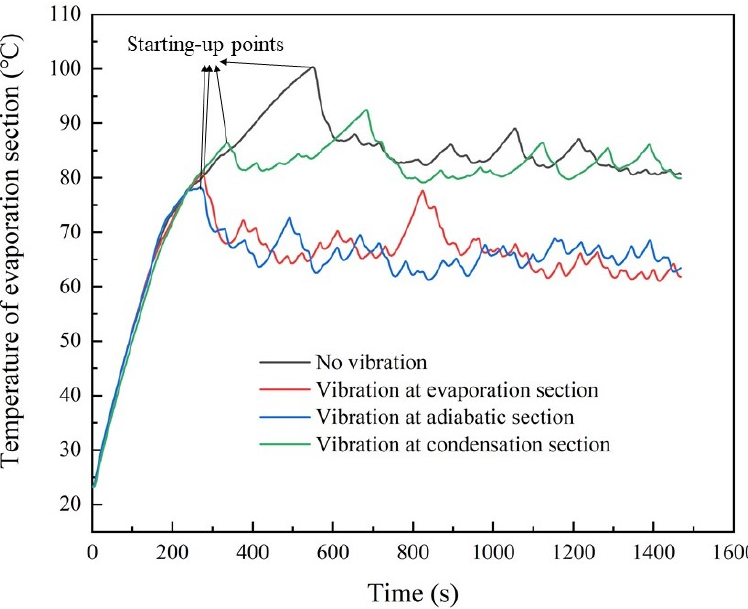
Figure 3. Temperature characteristics at the evaporation section of the PHP under different vibration positions (heating power 40 W).